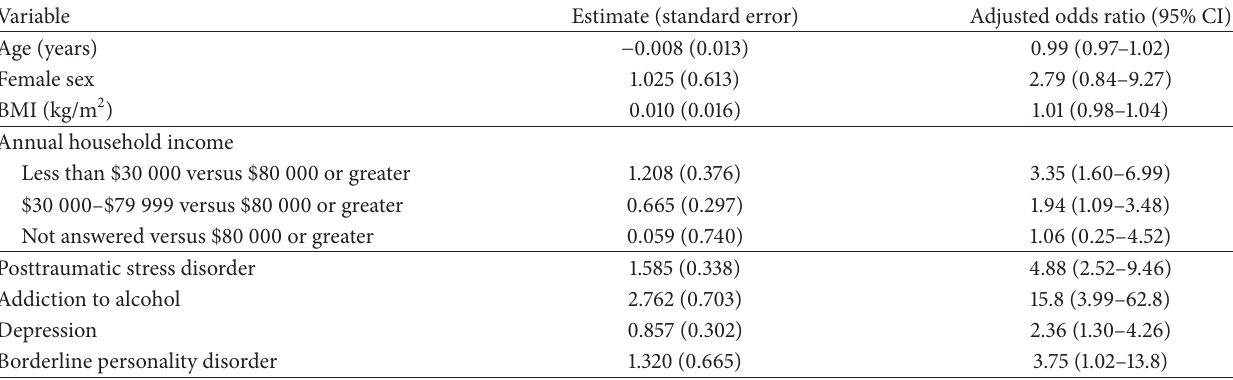
Table 2: Independent predictors of sexual abuse: multivariable logistic regression